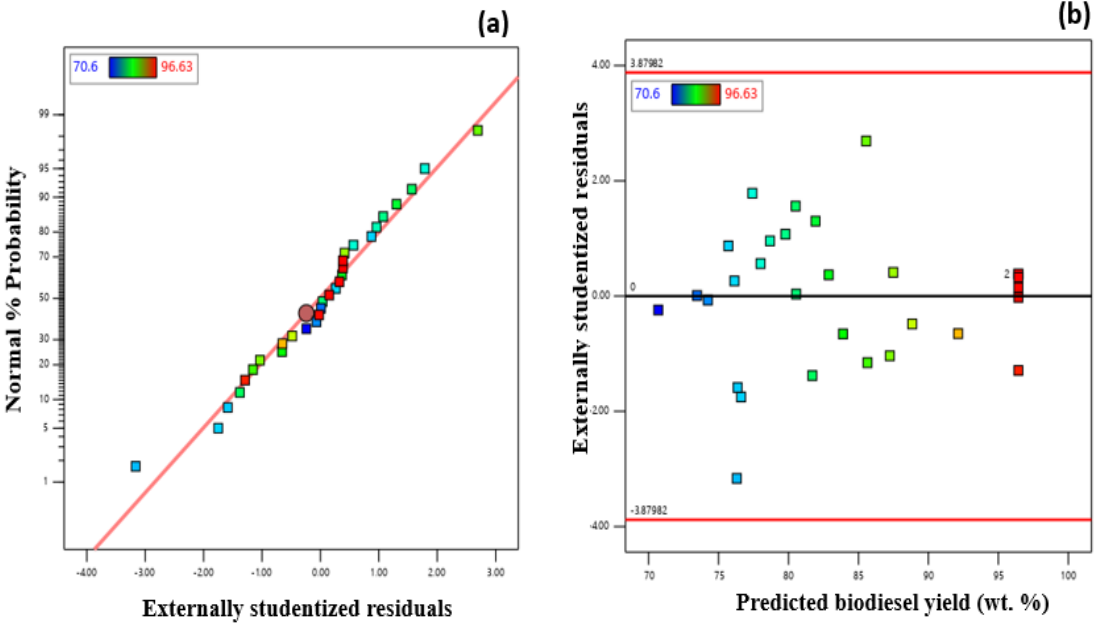
Figure 9. Diagnostic plots ( a ) Normal plot of residuals and ( b ) studentized residuals vs. the predicted biodiesel yield.